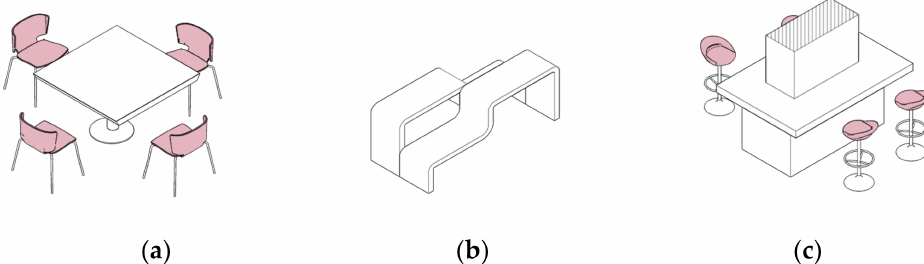
Figure 11. Three types of seat axonometric drawings: ( a ) square table; ( b ) two curved tables and chairs; and ( c ) table and chairs formed around a